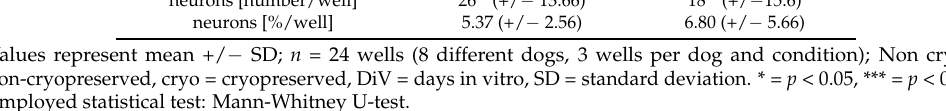
Table 1. Cellular composition of non-cryo and cryo cultures at 6 DiV. Condition